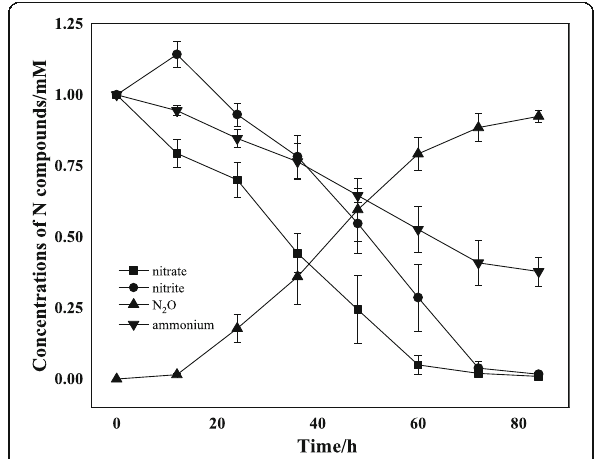
Fig. 1 Degradation of nitrate, nitrite, and ammonium by Halomicrobium sp. ZPS1 at NaCl concentration of